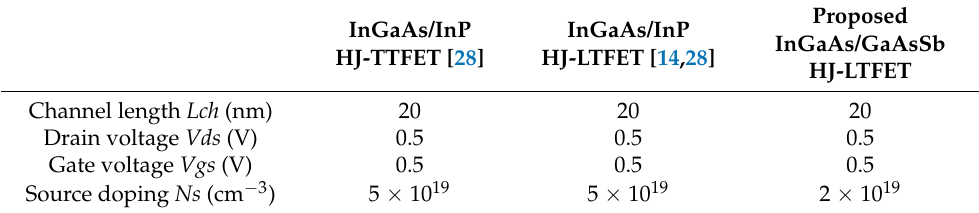
Table 1. Comparison with key parameters of similar device